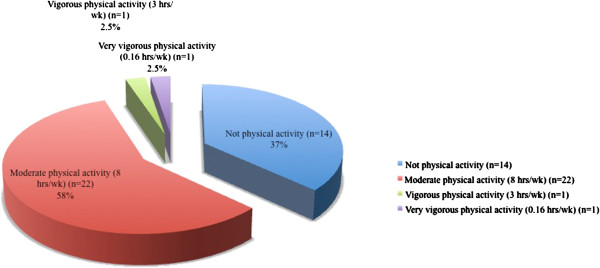
Dedication to physical activity.